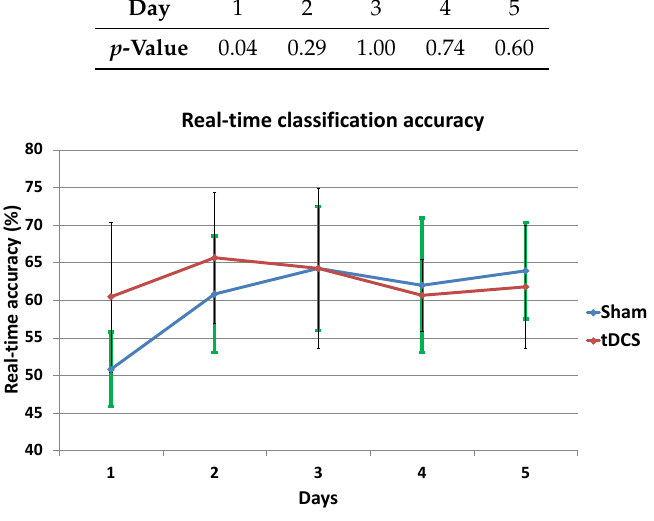
Figure 4. Mean real-time accuracy for all subjects of each group at each day.